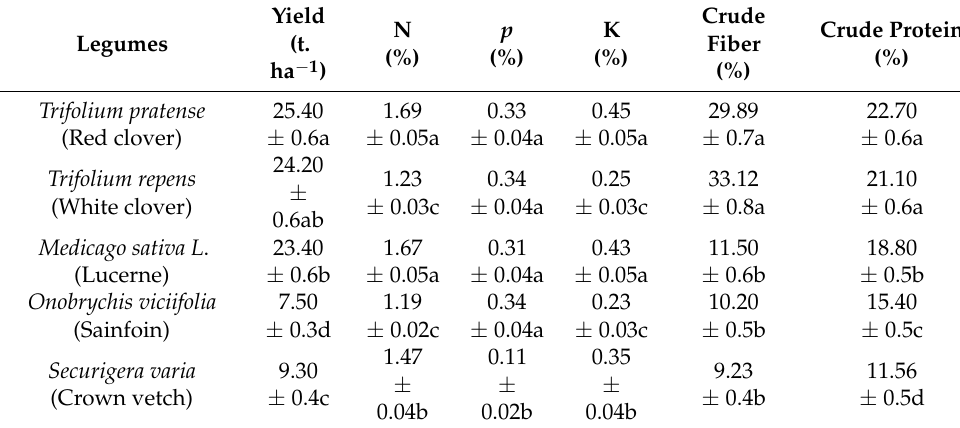
Table 8. Yield and leaf nutrient profile of prominent